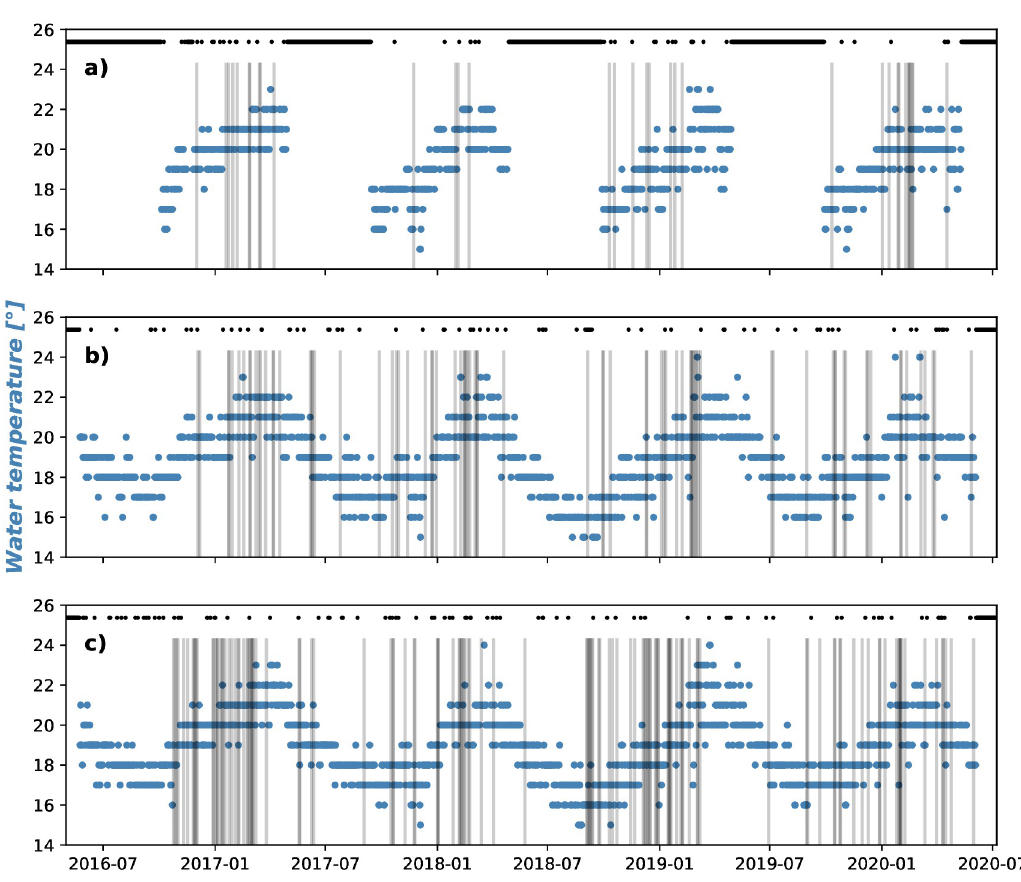
Fig 2. Time series of the water temperature reported from 2016 to 2020 (Blue circles) for a) Clovelly, b) Coogee, c) Maroubra. Days when beachings have been reported are shown by grey bars. Days when no beaching report is available (NaN) are scattered in black and shown at the